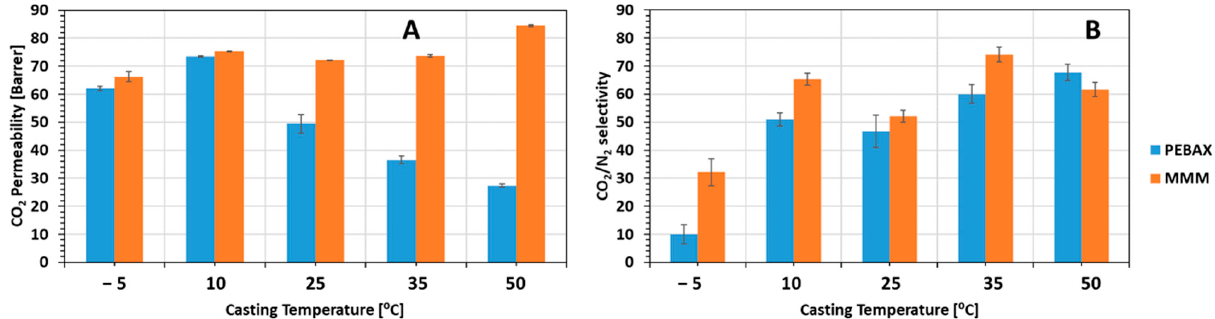
Figure 8. Variation of CO 2 permeability ( A ) and CO 2 /N 2 selectivity ( B ) as a function of the casting temperature for neat PEBAX (Blue) and MMMs (Orange).